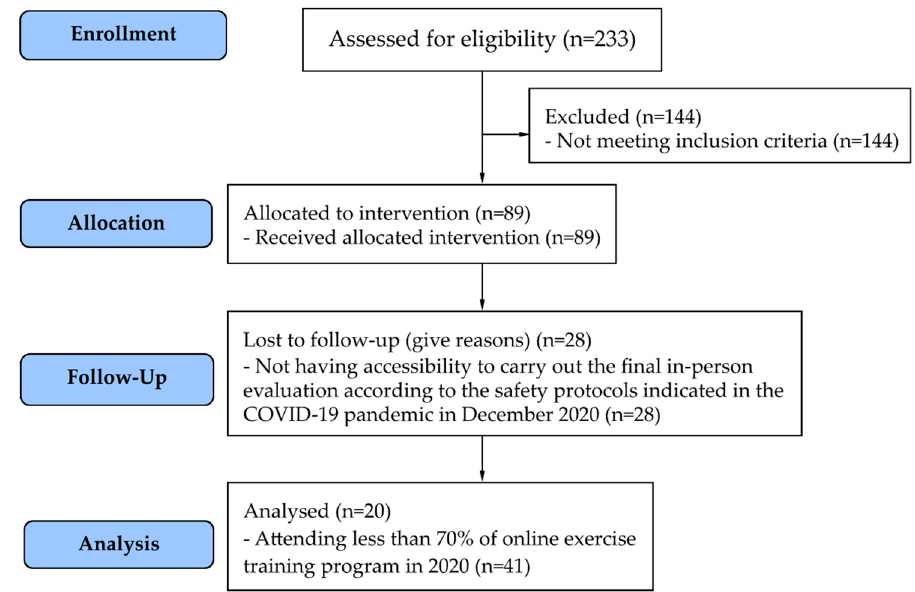
Figure 1. Sample distribution flow chart according to the inclusion and exclusion criteria.